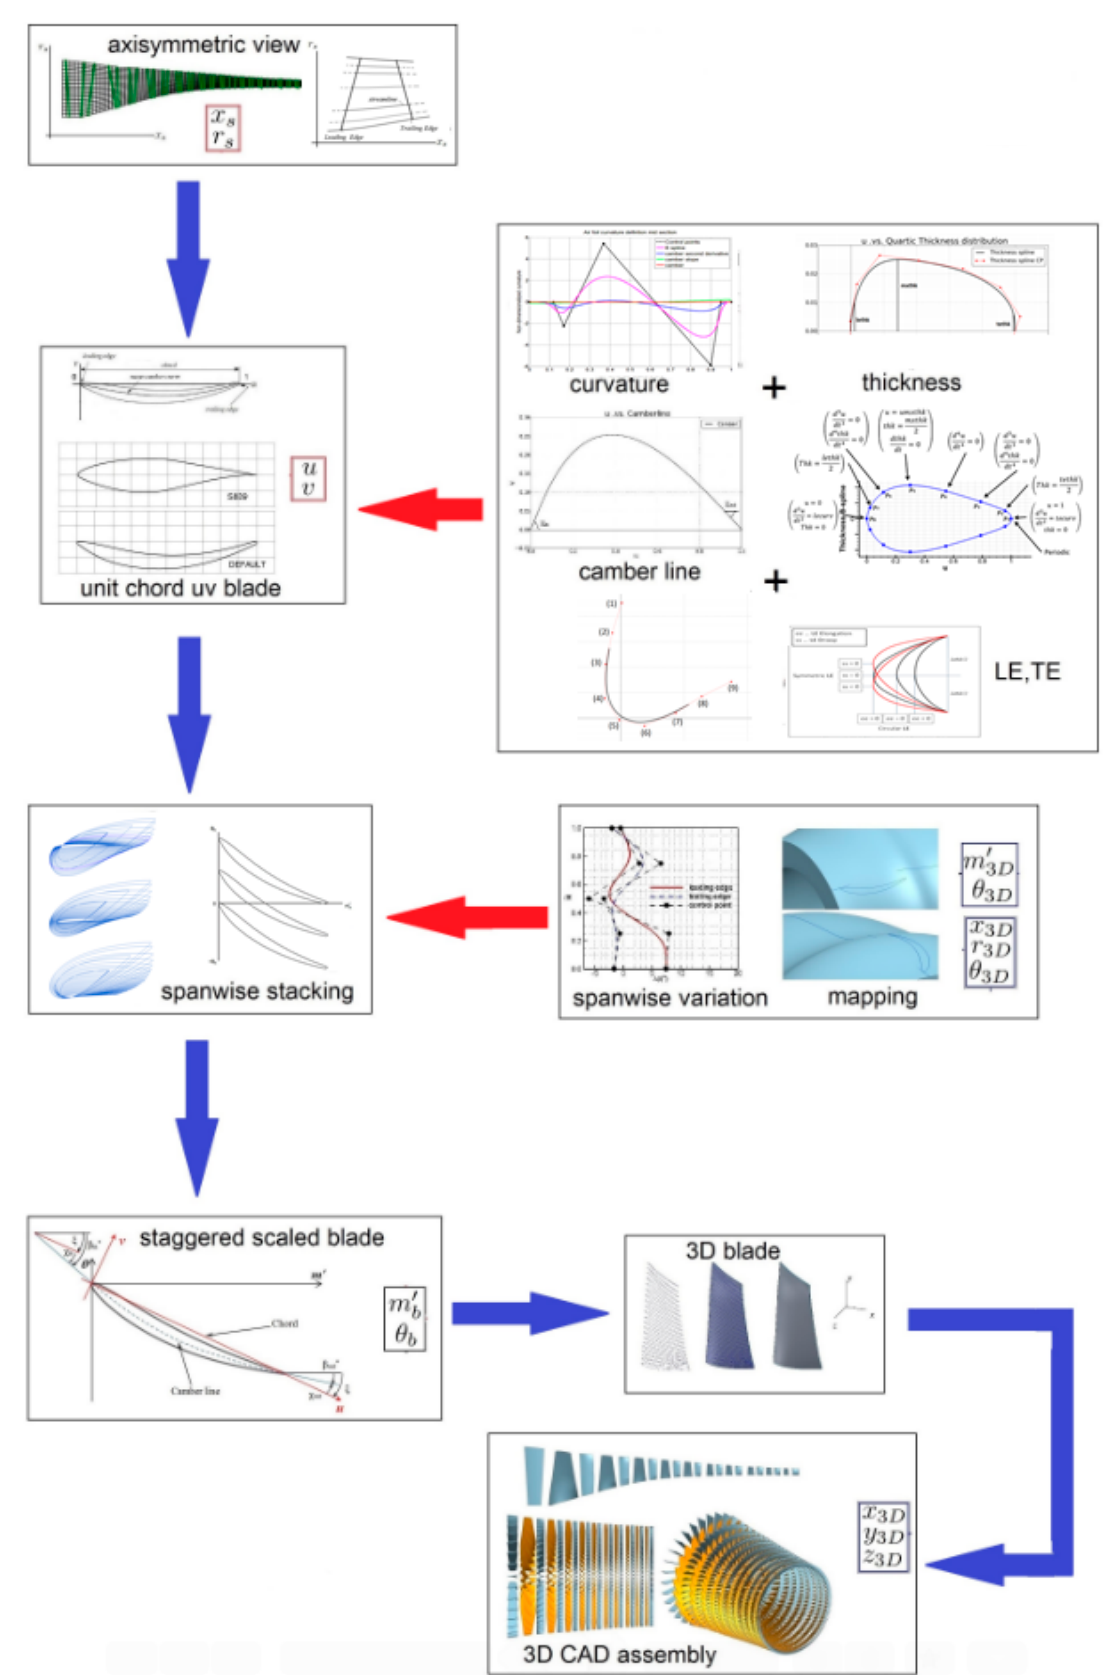
Figure 1. Flowchart of the entire parametric 3D blade generation process.